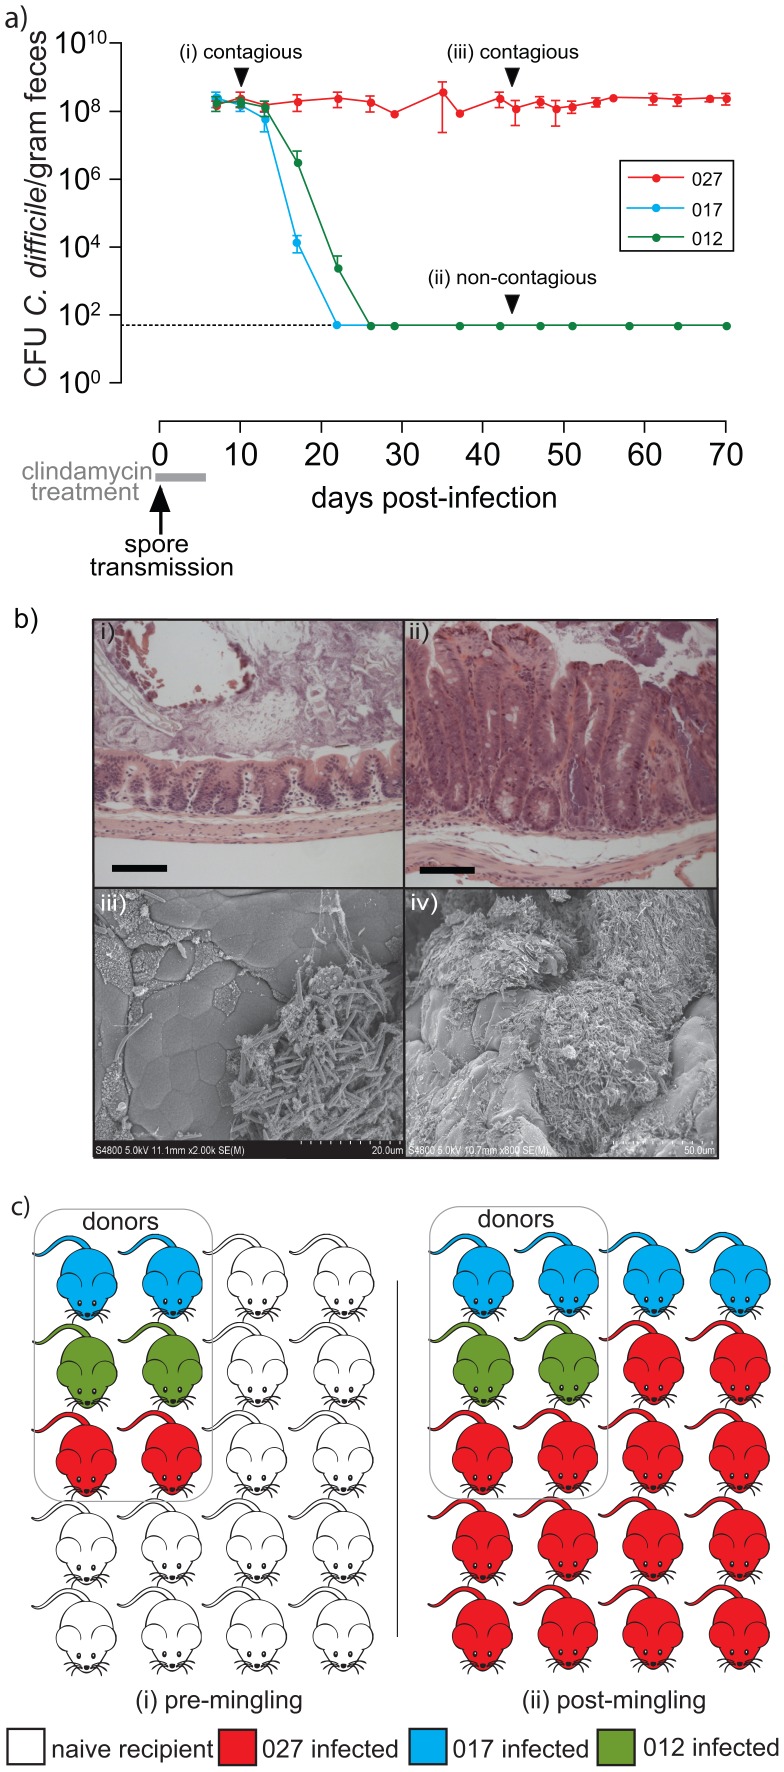
Epidemic C. difficile 027/BI causes persistent infection with enhanced transmissibility compared to other virulent variants.a) Representative fecal shedding patterns from C57BL/6 mice (n = 5 mice per group) simultaneously treated with clindamycin and exposed to human virulent C. difficile spores to mimic natural transmission. Mice were infected with C. difficile ribotype 027 (strain BI-7; n = 300), 017 (strain M68; n = 240) and 012 (strain 630; n = 50). Mice supershedding high-levels of C. difficile (>108 CFU/gram fresh feces) are highly contagious (i and iii) whereas mice shedding low-levels of C. difficile (ii; <102 CFU/gram fresh feces) are non-contagious (Figure S3). Broken horizontal line indicates culture detection limit of 50 CFU/gram feces. b) i–ii) hematoxylin and eosin staining to compare cecal pathology of i) healthy, clindamycin treated mice to ii) persistent C. difficile 027/BI-7 supershedders (day 49 post-infection; C57BL/6) that display signs of hyperplasia, edema and immune cell filtrate. Scale bars represent 100 µm. iii–iv) Scanning electron micrographs of illustrating the presence of C. difficile microcolonies (iii) and biofilm-like structures (iv) on the intestinal mucosal surface of persistent supershedders. Scale bars shown in bottom right corner. c) C. difficile 027/BI-7 outcompetes C. difficile 012/R and 017/CF within susceptible host populations. Shown is the summary of two independent experiments that included 6 C. difficile infected donor mice (2 donors infected individually with either C. difficile ribotype 012, 017 or 027) housed with 14 naïve recipient mice for 30 days. The transmission rate of C. difficile 027/BI-7 infected mice is significantly higher (p<1.1e−4) than that of C. difficile 012/630 (p<0.02) or 017/M68 (p<0.22) infected mice.